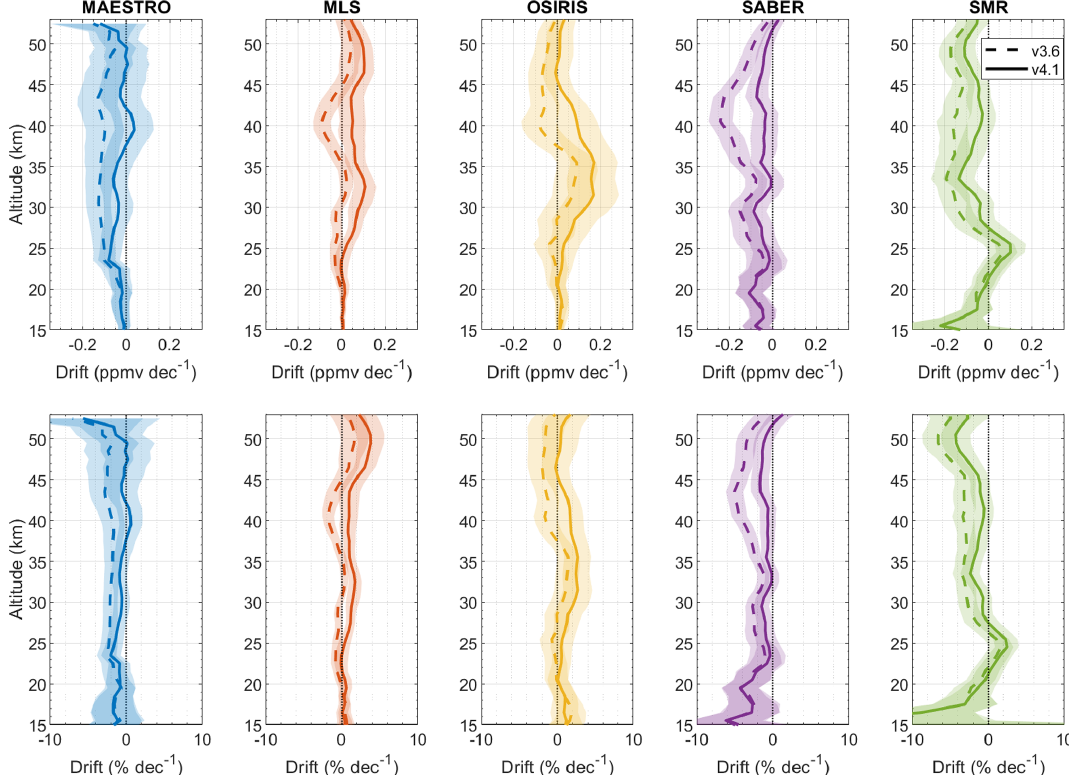
Figure 4. Drift profiles (curves) and corresponding 99% confidence bounds (semitransparent shaded regions) for comparisons between v3.6 and v4.1 ACE-FTS O 3 and MAESTRO (blue), MLS (red), OSIRIS (yellow), SABER (purple), and SMR (green) with coincidence criteria of within 6h and 300km for all coincident profiles within 2004–2020. Results in ppmv per decade (top) and in percent per decade (bottom).